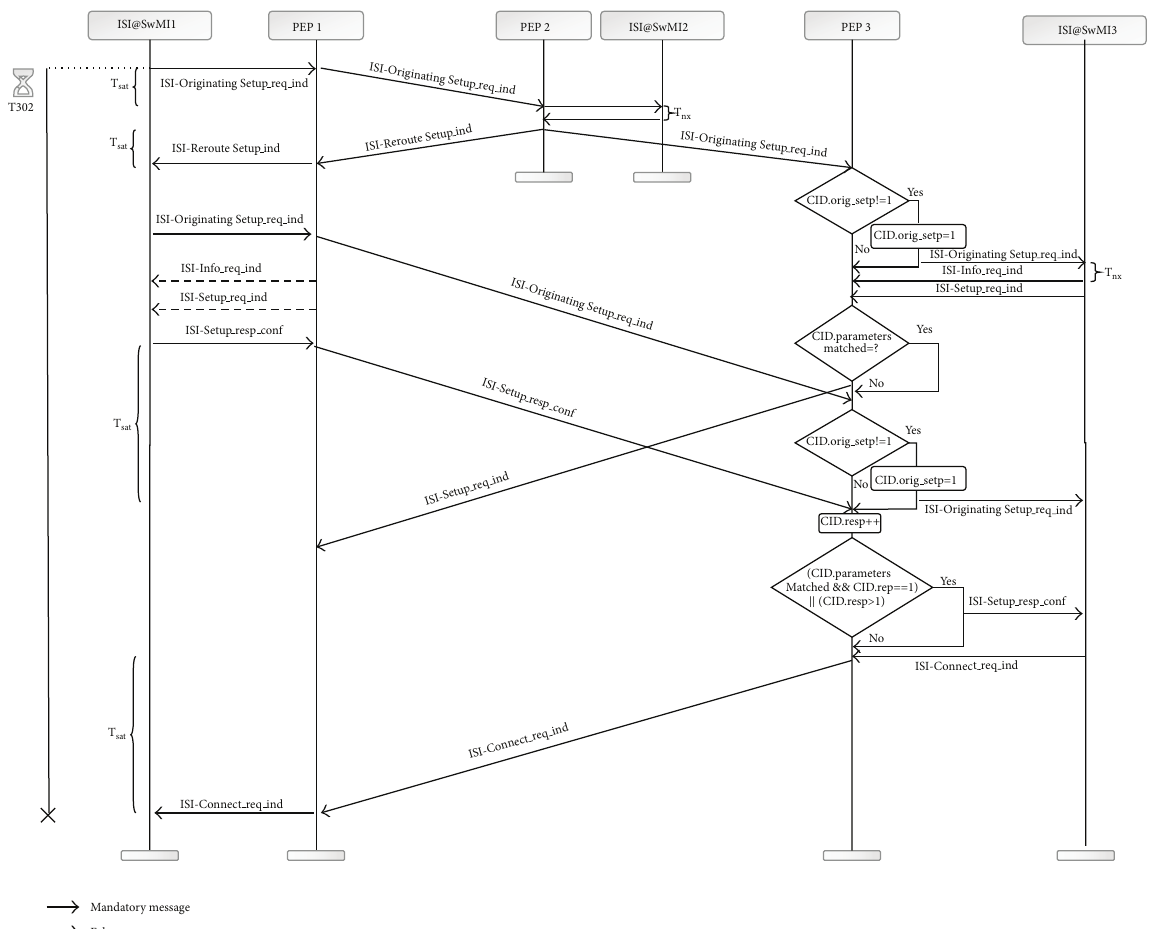
Figure 8: ISI information flow sequence with PEPs, unacknowledged group call scenario